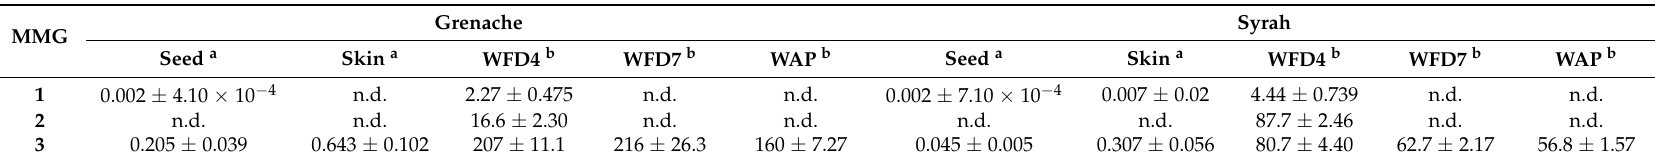
Table 1. Monomers of (epi) catechin monoglycoside (MMG) isomers measured in grape seed and skin, and during winemaking at wine fermentation day 4 (WFD4), day 7 (WFD7), and wine after pressing (WAP).